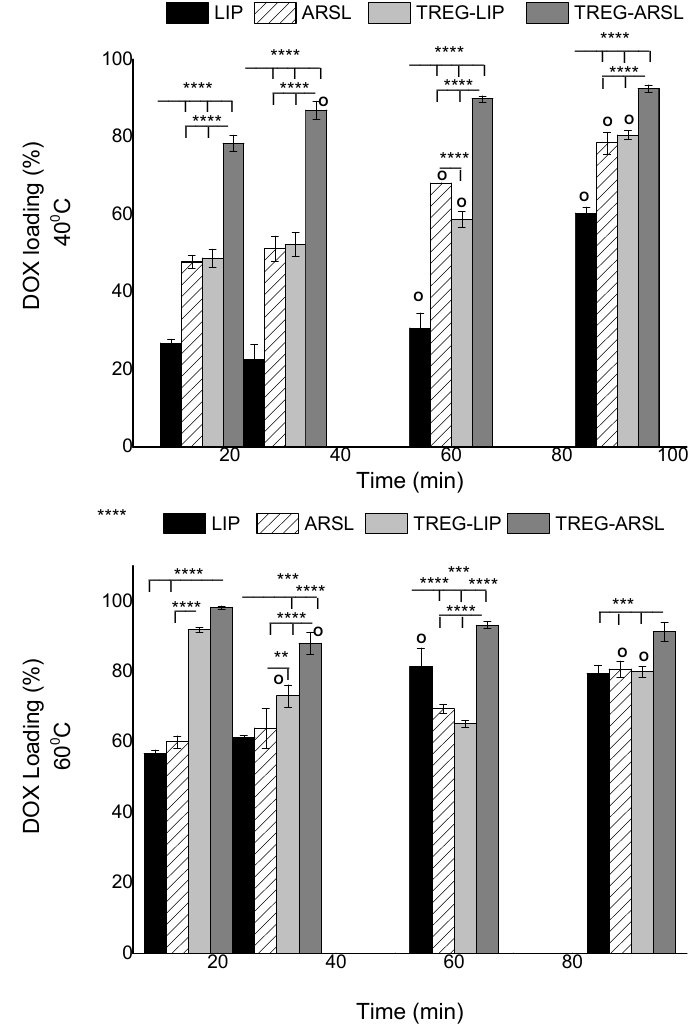
Figure 5. DOX-loading (%) in various types of vesicles by remote loading method at 40 ◦ C and 60 ◦ C. **, *** and **** correspond to p < 0.01, p < 0.001 and p < 0.0001, Figure 5. DOX ‐ loading (%) in various types of vesicles by remote loading method at 40 °C and 60 °C. **, *** and **** correspond to p < 0.01, p < 0.001 and p < 0.0001, respectively